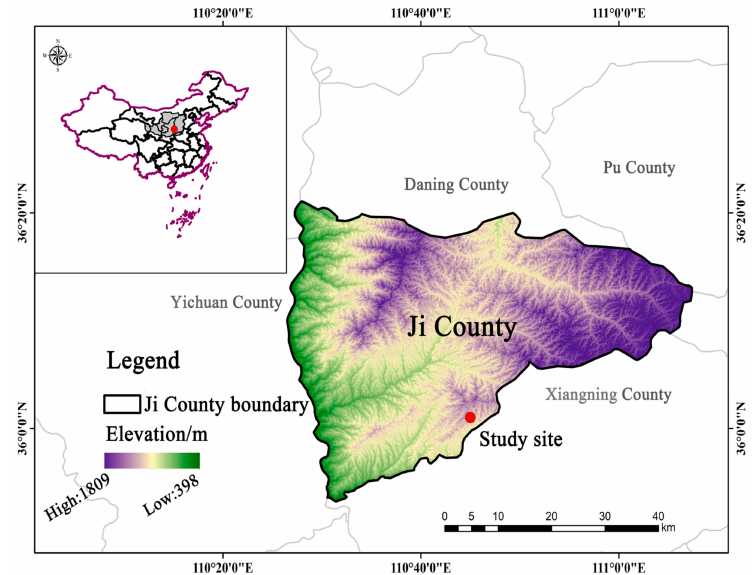
Figure 1. Geographical location of the study area.